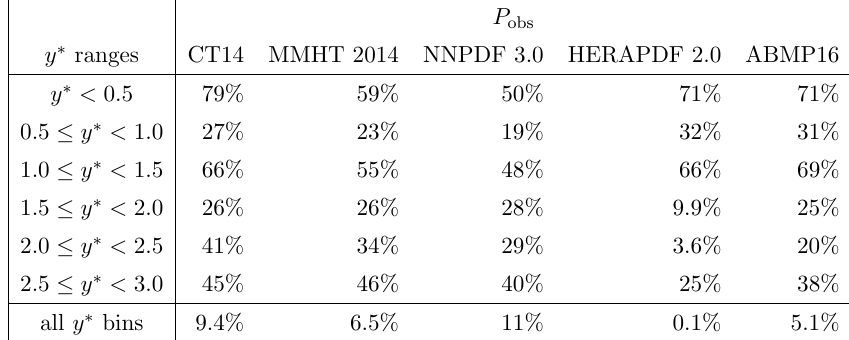
Table 4 . Summary of observed P obs values obtained from the comparison of the dijet cross-section and the NLO pQCD prediction corrected for non-perturbative and electroweak e(cid:11)ects for various PDF sets and for each individual y (cid:3) range. The last row of the table corresponds to a global (cid:12)t using all m jj and y (cid:3) bins of the dijet